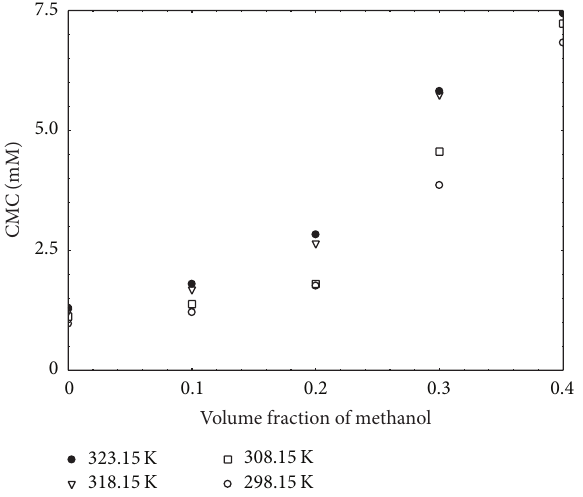
Figure8:Plotof (𝜂 𝑟 −1)/√𝑐 versus √𝑐 forCTABsolutionat308.15K.